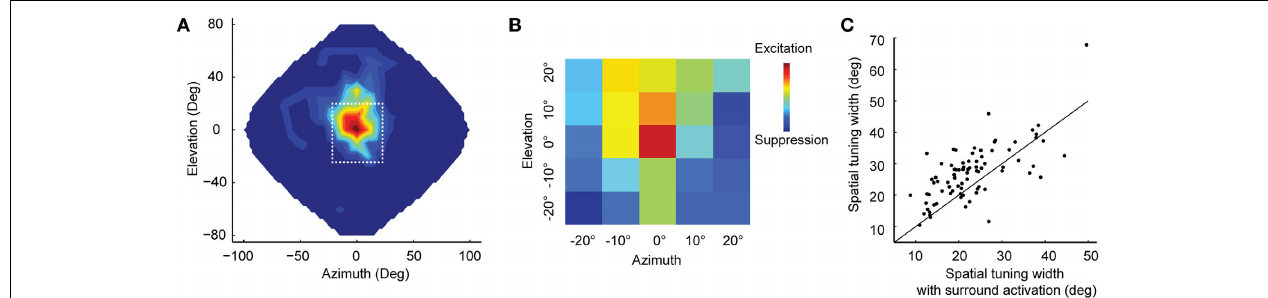
FIGURE 1 | Surround suppression in ICx. (A) Example spatial receptive field of an ICx neuron. Firing rates were interpolated across 144 speakers covering frontal space. The dotted line indicates the area shown in (B) . (B) A subset of speakers was used to analyze the center-surround receptive field with white noise stimulation. Each colored box represents the cell’s response to a